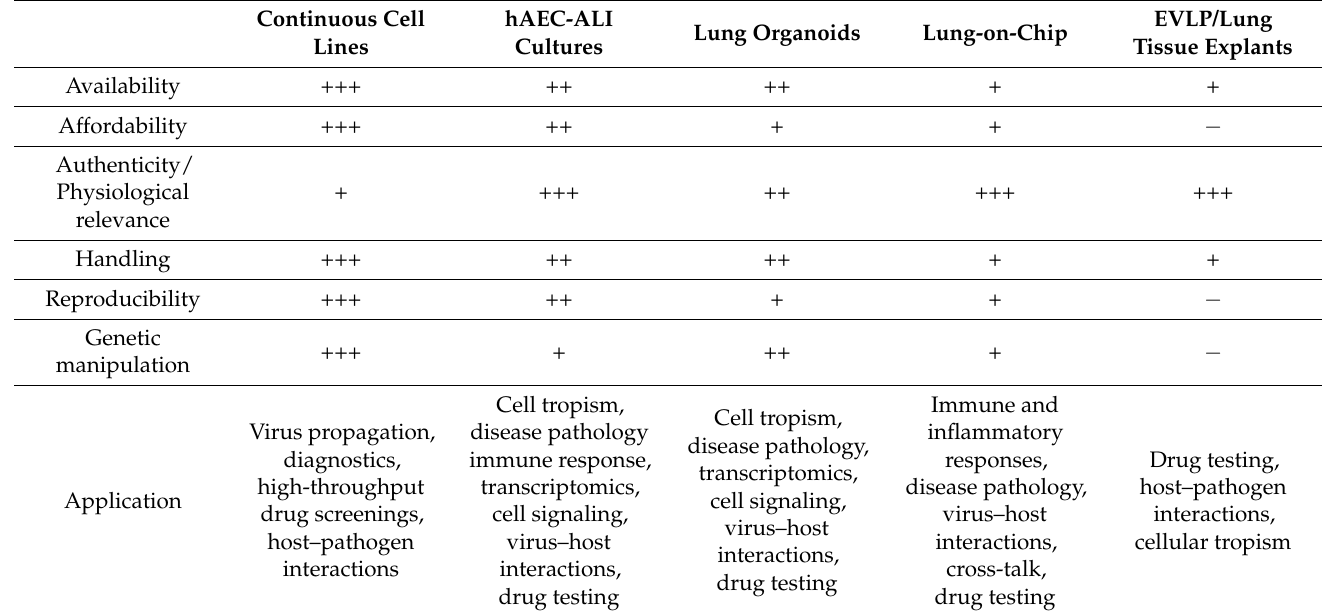
EVLP/Lung Tissue